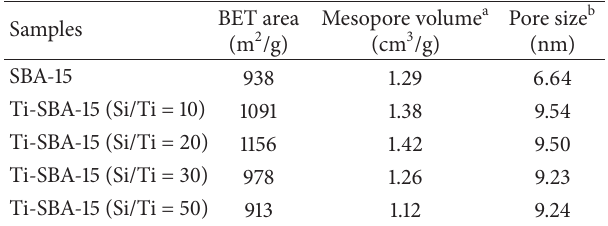
Table 1: Pore structure character parameters of SBA-15 and Ti-SBA- 15.